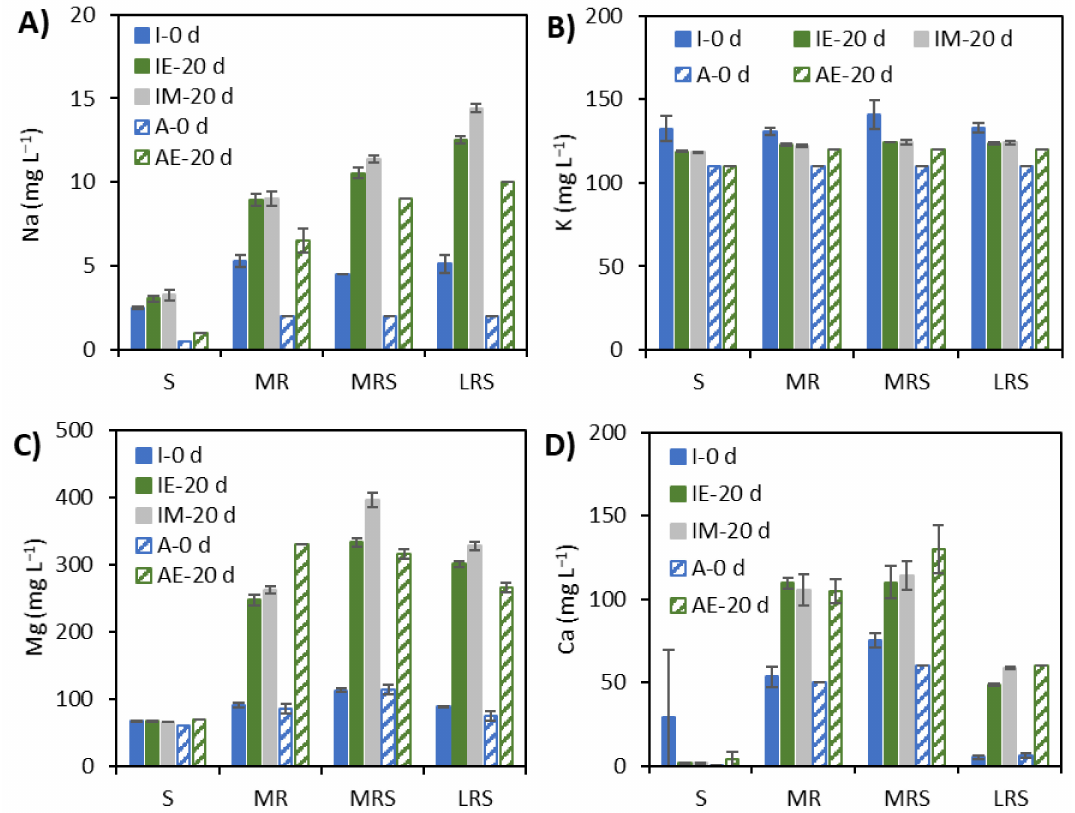
Figure 6. Concentrations of soluble elements: ( A ) sodium, ( B ) potassium, ( C ) magnesium and ( D ) calcium in inoculated (I) and abiotic (A) FPAs after incubation for 0 and 20 days under Earth gravity (E) and simulated microgravity (M) conditions in the presence of 12.5 mM Fe 3+ (S), 1% Mars regolith simulant (MR), 1% Mars regolith simulant plus 12.5 mM Fe 3+ (MRS) and 1% lunar regolith simulant 12.5 mM Fe 3+ (LRS). H 2 /CO 2 gas mixture was added to all cultures as source of electron donor and carbon source,